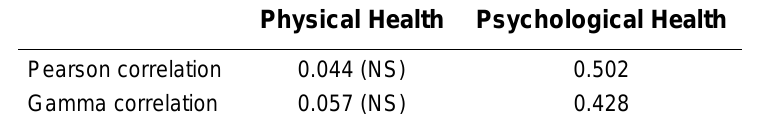
Correlations Between the 9-Item SOC Scale and